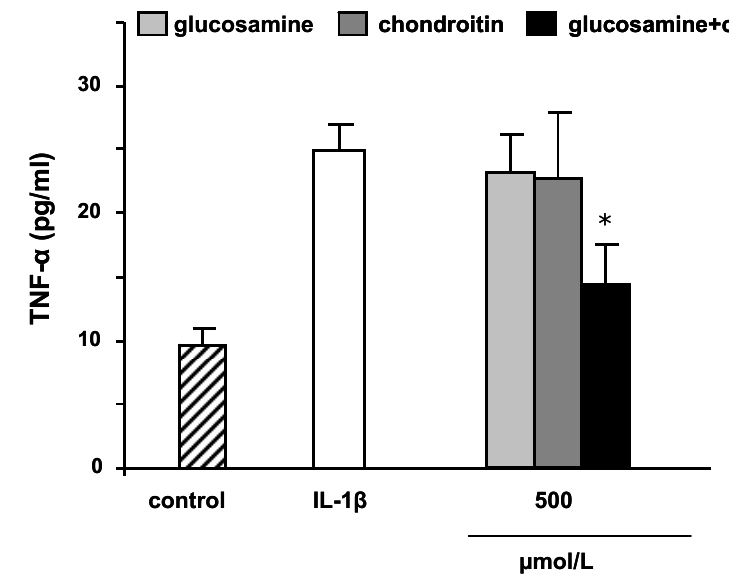
Figure 5. Effect of glucosamine and chondroitin on TNF α protein secretion in IL-1 β stimulated SW1353 cells. Cells were stimulated with IL-1 β (10 ng/mL) in the presence of 500 µmol/L of glucosamine, chondroitin and the combination of both test compounds for 24 h. Cell culture supernatants were collected and the amount of TNF α secreted by SW1353 cells was measured by specific ELISA. Data are means + SEM of three independent experiments performed in duplicate. * p < 0.05; compared to IL-1 β